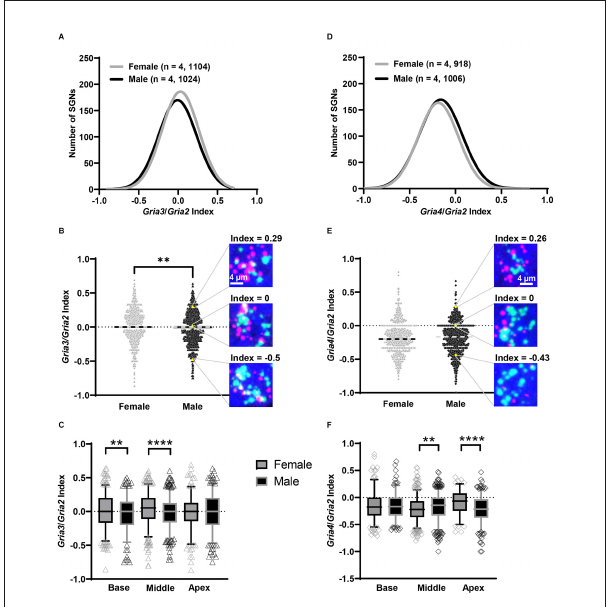
FIGURE6 SGN Gria3/Gria2 and Gria4/Gria2 indices vary by sex. (A–C) Subpopulations of SGNs based on the Gria3/Gria2 index value. (A) Histogram showing the total distribution of SGN GriaA3/Gria2 indices for females (gray line) and males (black line). Numbers in parentheses indicate the number of mice, followed by the total number of SGNs. (B) Violin plots of the index values for Gria3/Gria2 on each SGN for the whole cochlea. To the right are representative images of SGNs in a male with different index values based on Gria3 (magenta) vs. Gria2 (green) counts: Gria3 > Gria2 (top, positive index value), Gria3 = Gria2 (middle, index value of 0), and Gria3 < Gria2 (bottom, negative index value). The position of each example SGN within the violin plot is represented with a yellow triangle. The dashed line on each violin plot represents the median. (C) Whisker plots show the index values for Gria3/Gria2 on SGNs of the basal, middle, and apical cochlea turns. Females (gray symbols) had higher average Gria3/Gria2 index values in the base and middle compared to males (black symbols). Whiskers display the 5 and 95 percentiles. (D–F) Subpopulations of SGNs based on the Gria4/Gria2 index value. (D) Histogram showing the total distribution of SGN Gria4/Gria2 indices for females (gray line) and males (black line). Numbers in parentheses indicate the number of mice, followed by the total number of SGNs. (E) Violin plots of the index values for Gria4/Gria2 on each SGN for the whole cochlea. To the right are representative images of SGNs in a male with different index values based on Gria4 (magenta) vs. Gria2 (green) counts: Gria4 > Gria2 (top, positive index value), Gria4 = Gria2 (middle, index value of 0), Gria4 < Gria2 (bottom, negative index value). The position of each example SGN within the violin plot is represented with a yellow diamond. The dashed line on each violin plot represents the median. (F) Whisker plots show the index values for Gria4/Gria2 on SGNs of the base, middle, and apex cochlea turns. Males (black symbols) had on average higher Gria4/Gria2 index values in the middle, while females (gray symbols) had a higher average Gria4/Gria2 index in the apex. Whiskers display the 5 and 95 percentiles. Unpaired t -test, ** p < 0.01, **** p < 0.0002.